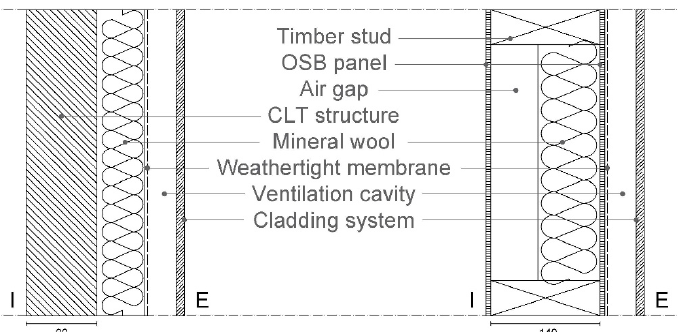
Figure 1. Schematic representation of the wall assemblies used as two reference scenarios: Mass- timber (CLT) wall on the left, and Timber-framed (TF) wall on the right. I: internal surface, E: external surface [23]. Table 2. Wall assemblies’ description. Layers are listed from indoor to outdoor, minimum R-value requirements for each climate zone [6] is noted. Wall Typologies Functional Layer